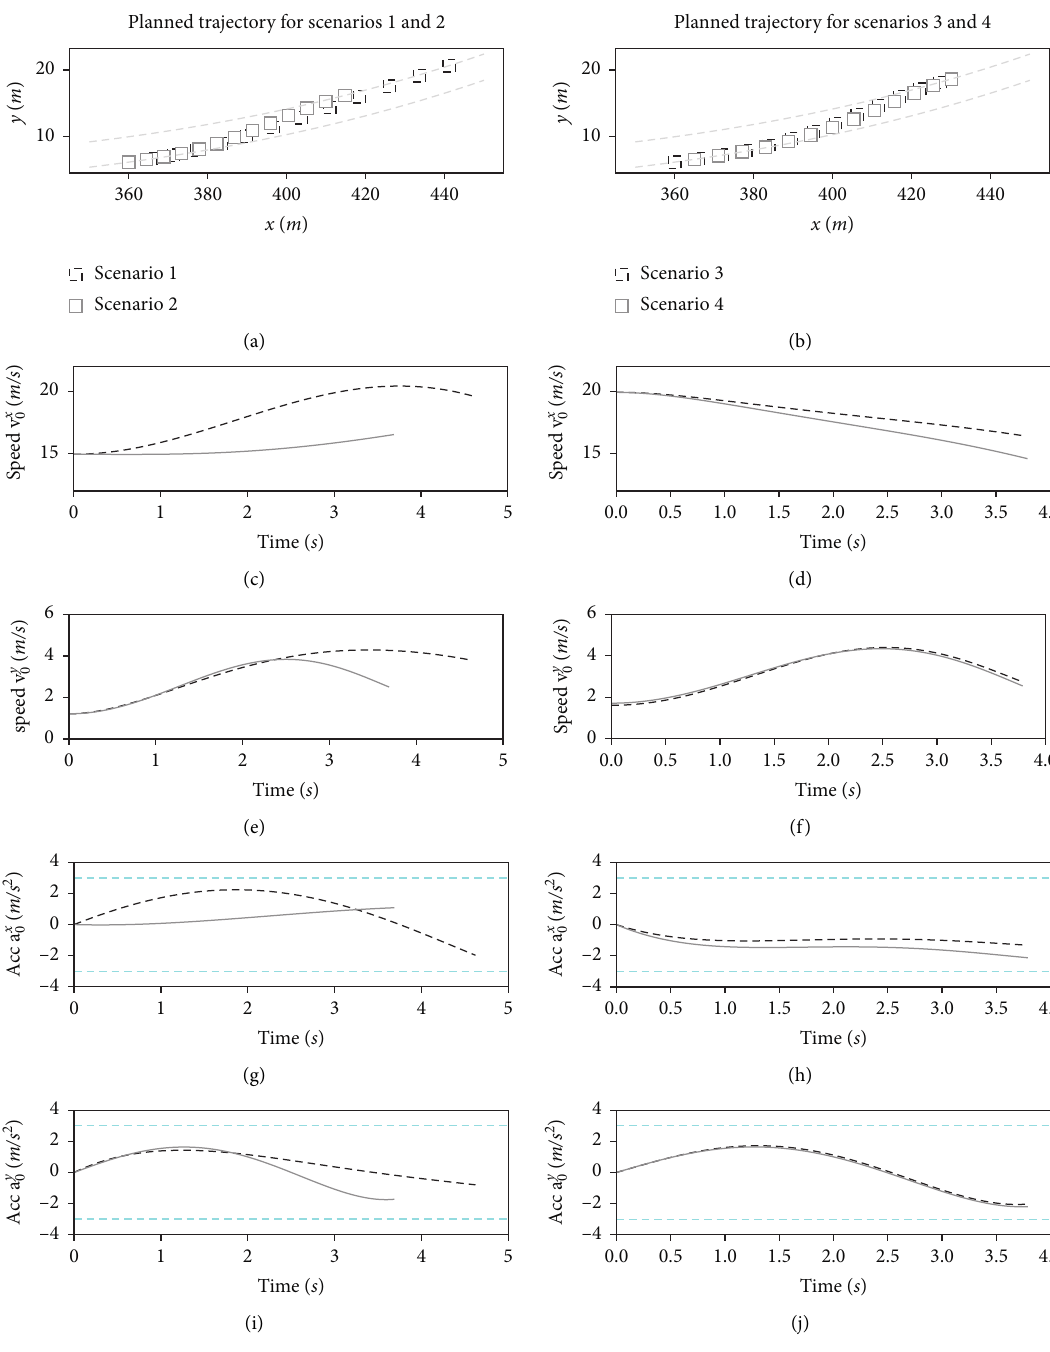
Figure 9: Planned trajectory of vehicle 0 for scenarios 1, 2, 3, and